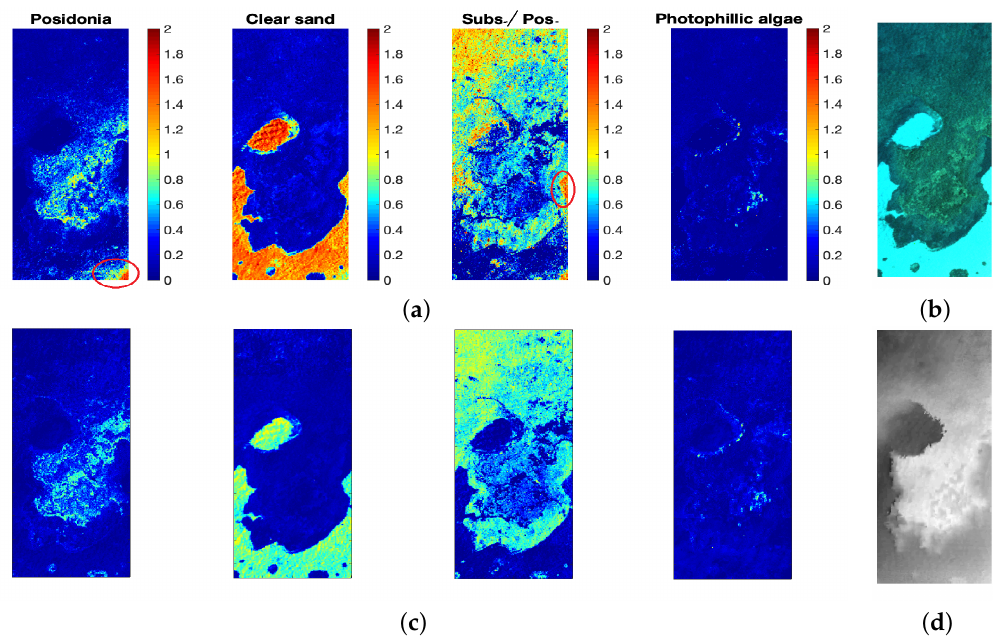
Figure 9. ( a ) Coefficients ( C est ), estimated using LS inversion; ( b ) Airborne reflectance data of the Porquerolles Island, taken using the Hyspex hyperspectral sensor (sub-surface correction); ( c ) Abundances ( A est , estimated using WADJUM ); ( d ) Bathymetry provided by the Litto 3 D database. The depth is between 1.8 m (white) and 6.1 m